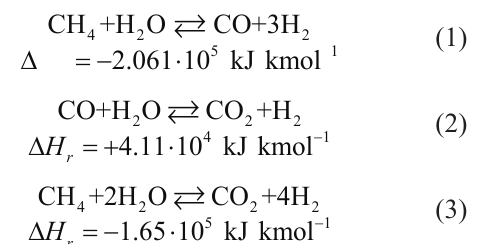
Fig. 1 indicates a simple schematic of a reform- er tube. Similar to other modelling studies, our as- sumptions were as